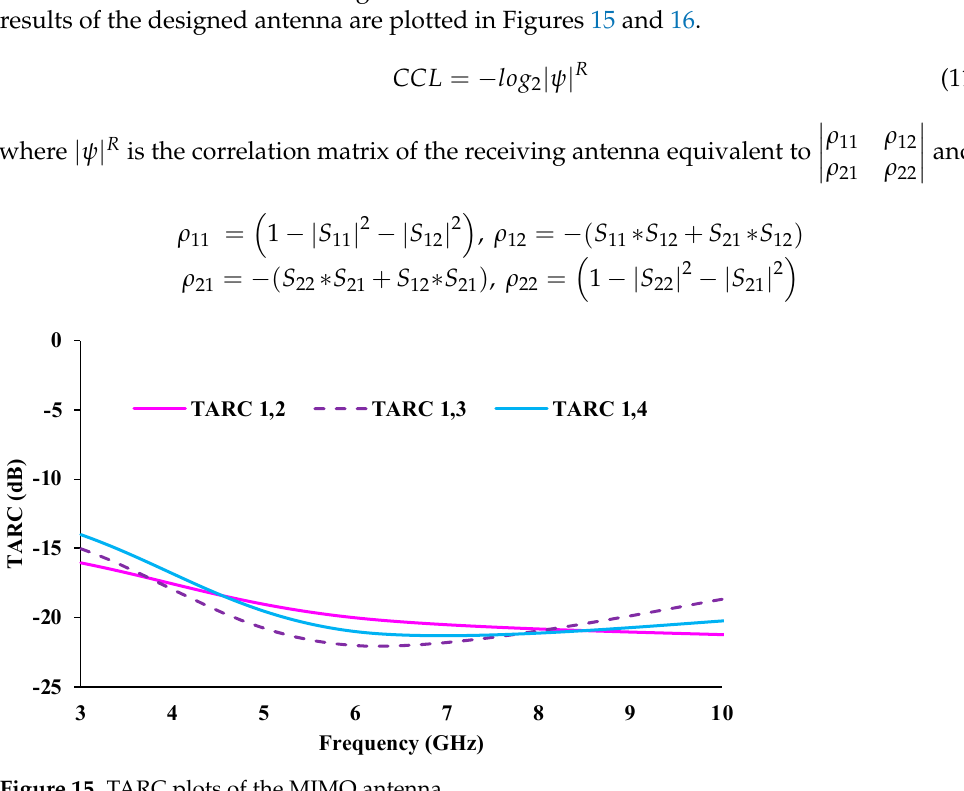
Figure 15. TARC plots of the MIMO antenna.